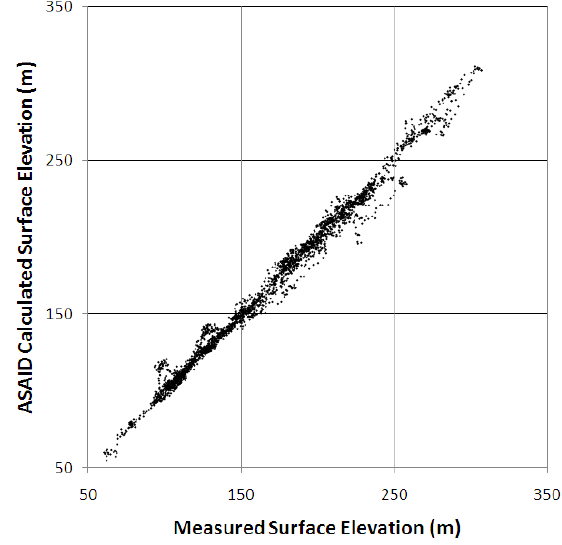
Figure 8. Surface elevations measured by British Antarctic Survey near grounded ice boundary of Ronne Ice Shelf versus surface elevations at the same locations extracted from a photoclinometry DEM produced by ASAID.